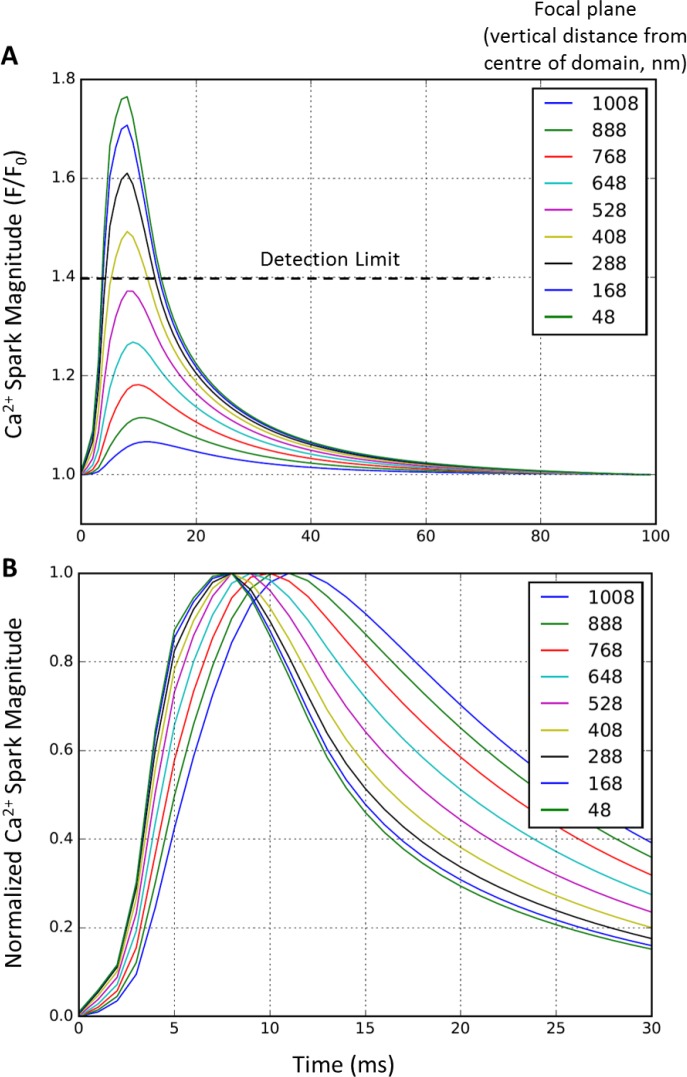
Effect of focal plane on Ca2+ spark detection and kinetics.To examine whether out-of-focus Ca2+ release events could artefactually alter assessment of Ca2+ spark parameters, simulated Ca2+ release profiles were compared in ‘linescans’ collected at various depths of the 2 × 2 µm computational domain (54 RyR single cluster model). Vertical, stepwise displacement from the central plane resulted in a rapid decrease in measured spark amplitude (A). Indeed, events > 0.5 µm displaced from the focal plan were undetectable. While displacement of the focal plane also slowed apparent Ca2+ spark kinetics, such effects were negligible within the range where sparks were detectable (B).